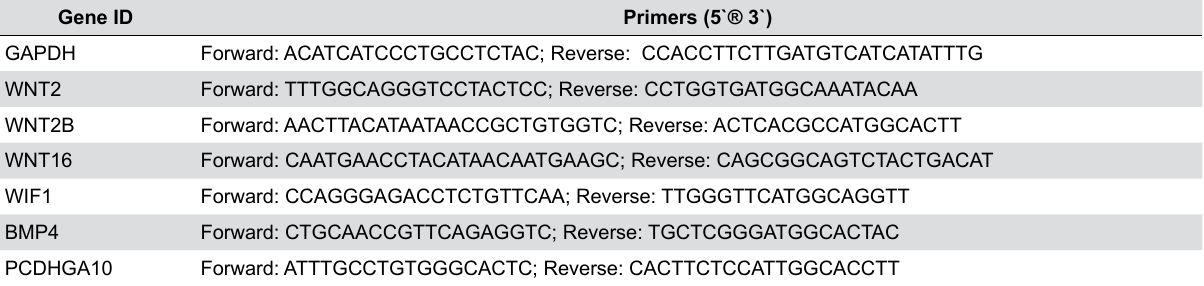
Transcriptome profile of highly osteoblastic/cementoblastic periodontal ligament cell Table 1- Specific primer sequence for quantitative Polymarase Chain Reaction (qPCR)